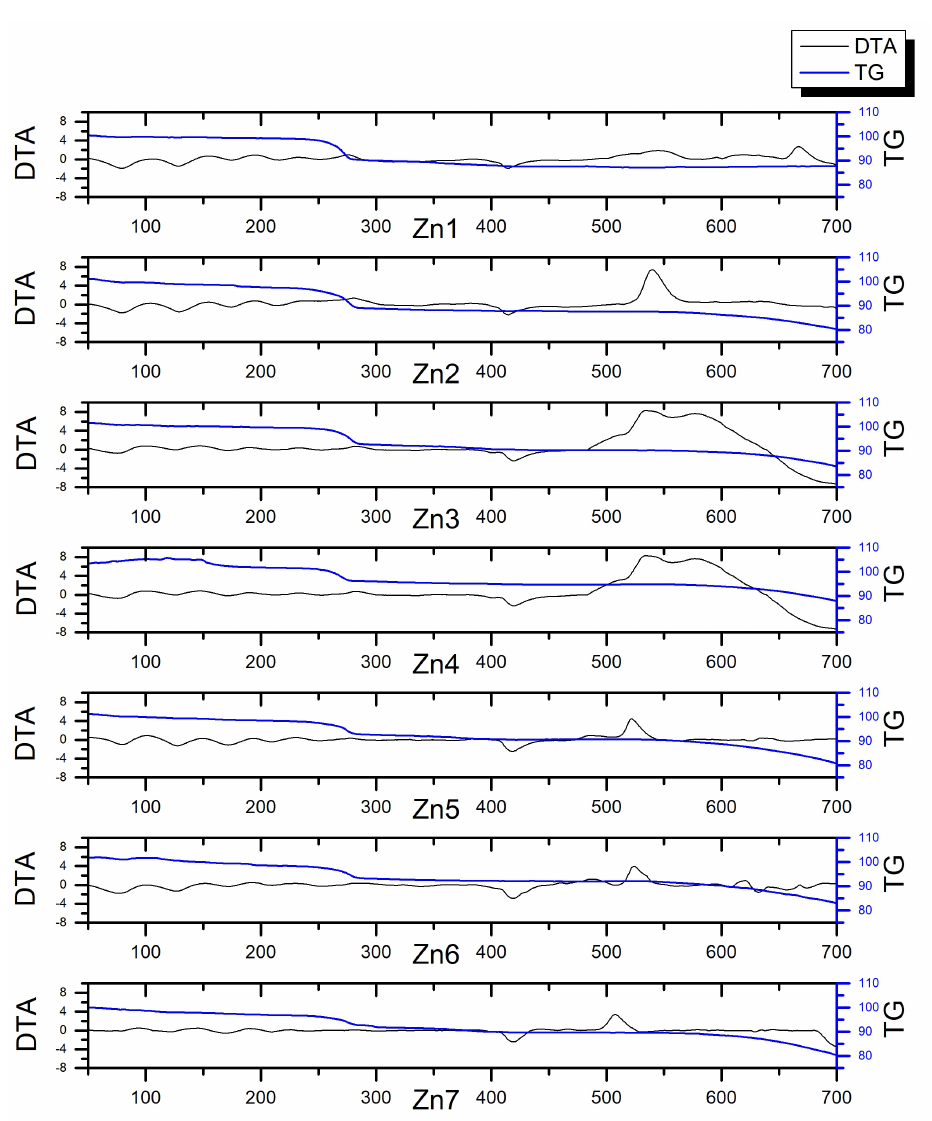
Figure A8. DTA and TG curves for Zn1–Zn7